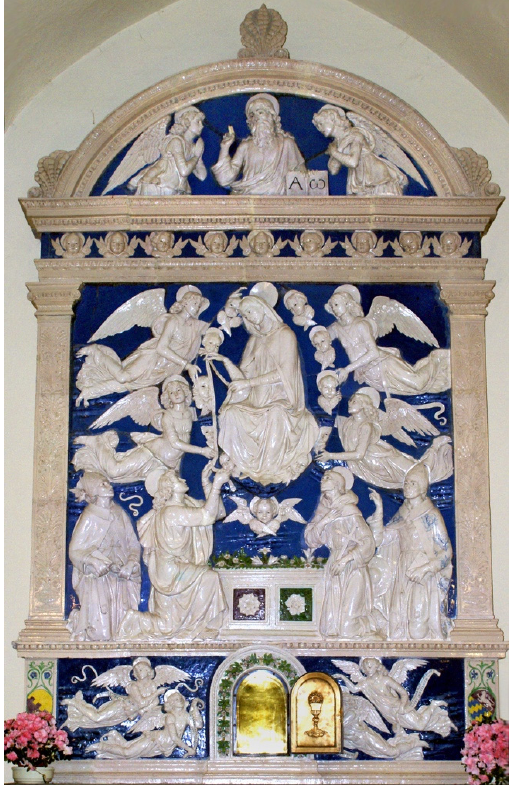
Figure 10. Andrea della Robbia, Madonna della Cintola , enamel terra cotta, Santa Maria degli Angeli, La Verna (photo source: Gunnar Bach Pedersen, Public domain, via Wikimedia Commons).